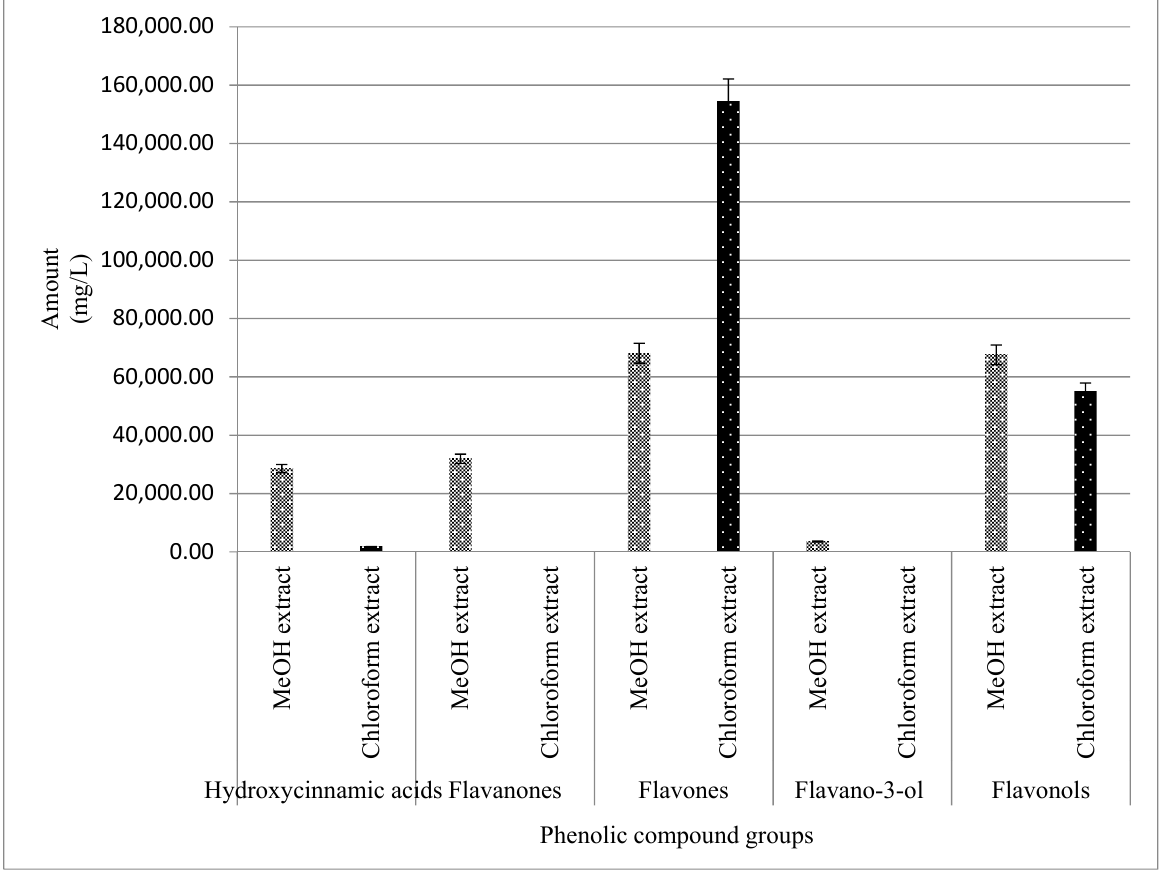
Figure 4. Amount of phenolic compounds quantitated from the methanol and chloroform extracts of E. africanus . Table 4. Linearity, LOD and LOQ of the chemical markers used as